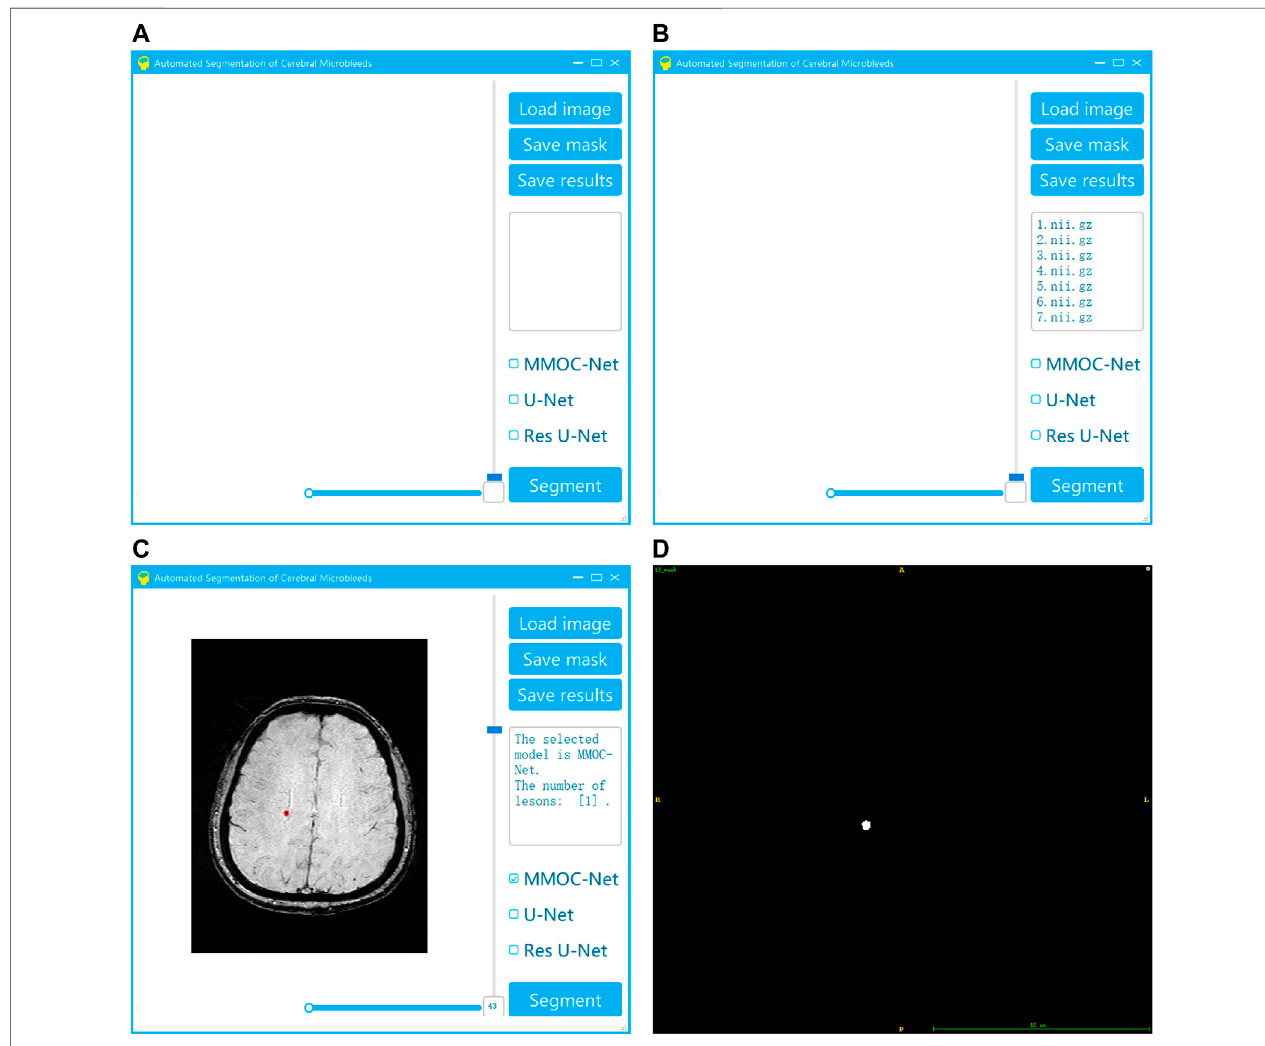
FIGURE 9 | Visualization system for the automatic segmentation of medical small targets. (A) Interface of system startup; (B) Selection of the original image and segmentation method; (C) Running the segmentation to obtain the results; (D) Exporting the segmentation results.